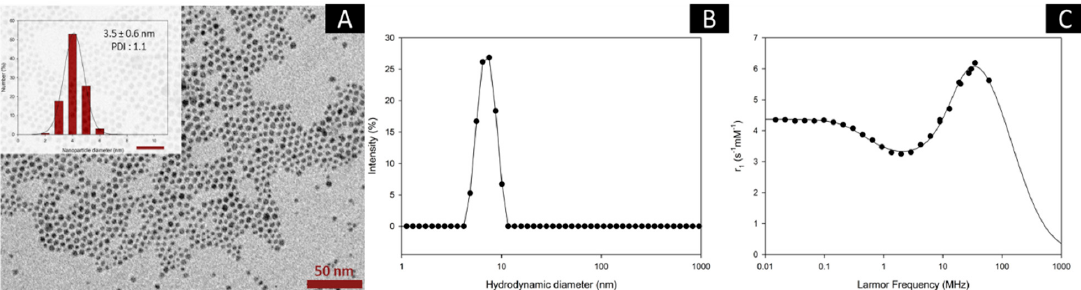
Figure 1. TEM image of the VSION in THF. The scale bar corresponds to 50 nm. The inset shows the size distribution: 3.5 ± 0.6 nm (PDI: 1.1) ( A ); Size distribution in intensity as measured by PCS ( B ); 1 H NMRD profile, recorded at 37 °C in THF ( C ).